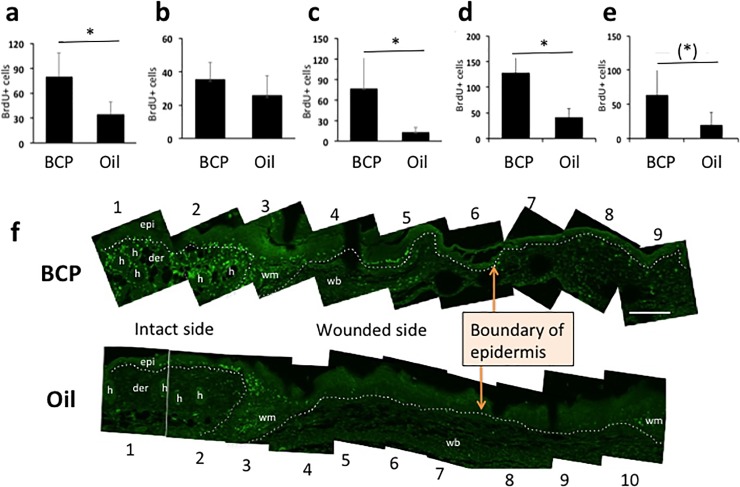
BrdU+ cells in the epidermis and dermis.(a) BrdU+ cells in the epidermis (epi in (f)) (Student T-test, T = 3.077, df = 8, P = 0.015, BCP, n = 5, Oil, n = 5), (b) BrdU+ cells in the wound margin (wm in (f)) (Student T-test, T = 1.343, df = 8, P = 0.216, BCP, n = 5, Oil, n = 5), (C) BrdU+ cells at the hair follicle (h in (f)) (Student T-test, T = 3.038, df = 8, P = 0.015, BCP, n = 5, Oil, n = 5). (d) BrdU+ cells at the dermis excluding wound margin (Student T-test, T = 4.645, df = 8, P = 0.002, BCP, n = 5, Oil, n = 5). (e) BrdU+ cells at the wound bed (Student T-test, T = 2.197, df = 8, P = 0.059, BCP, n = 5, Oil, n = 5). (f) Representative views of combined photos used in quantification for each group. h: hair follicle, epi: epidermis, der: dermis, wm: wound margin, wb: wound bed, scale bar: 200 μm. Numbers below and above the photos are operationally assigned numbers for explanation in the text on locations in the wound. Dotted lines show the boundaries between epidermis and dermis, dermis and wound margin zone, and wound margin zone and wound bed.